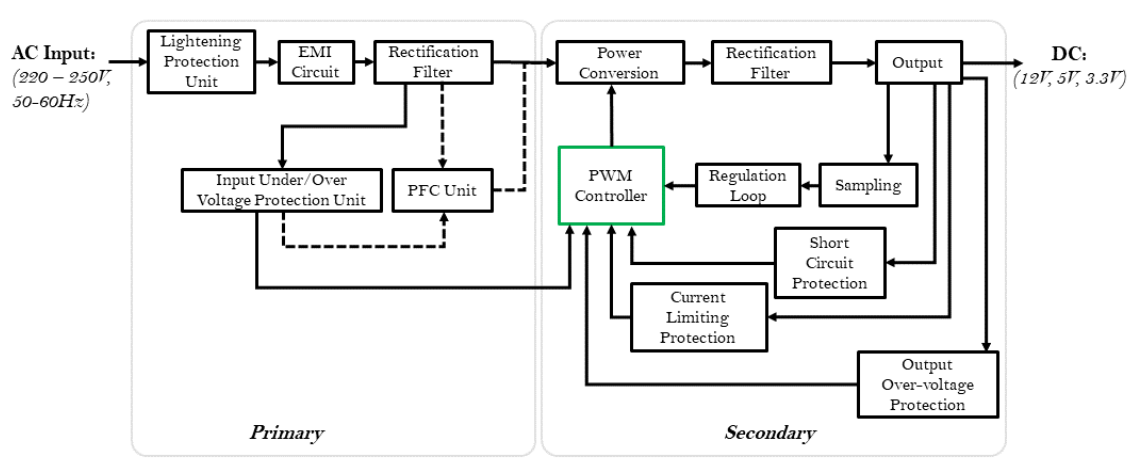
Figure 1. AC-DC Switched Mode Power Supply